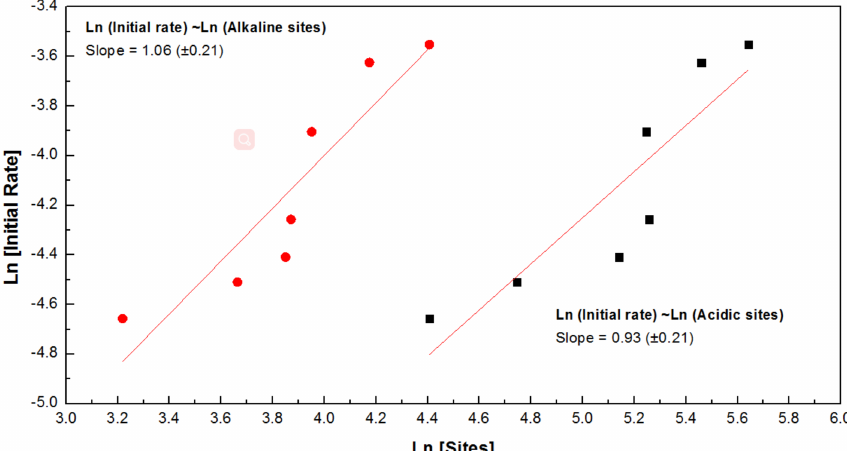
Figure 8. Kinetics study of the initial rate of DMC production contrast acidic/alkaline sites. Reaction conditions: Methanol 500 mmol; catalysts 0.2 g; CO 2 pressure 5 MPa; temperature 120 ◦ C; reaction time 60